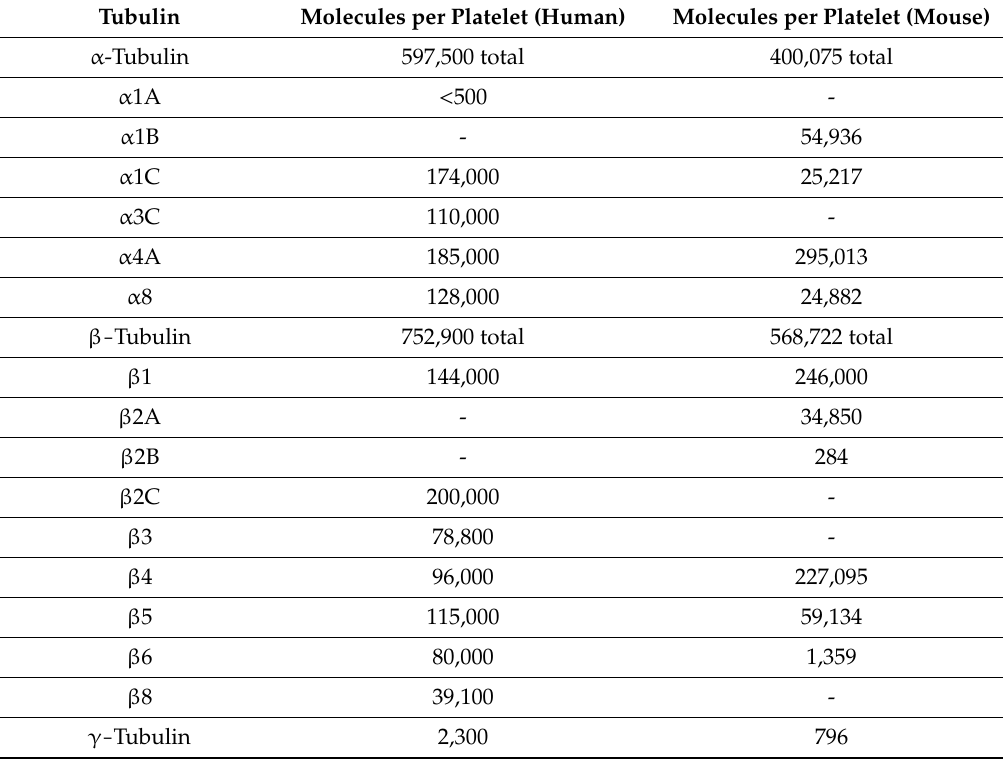
Table 1. Platelet cytoskeleton tubulin expression levels in human and mouse.